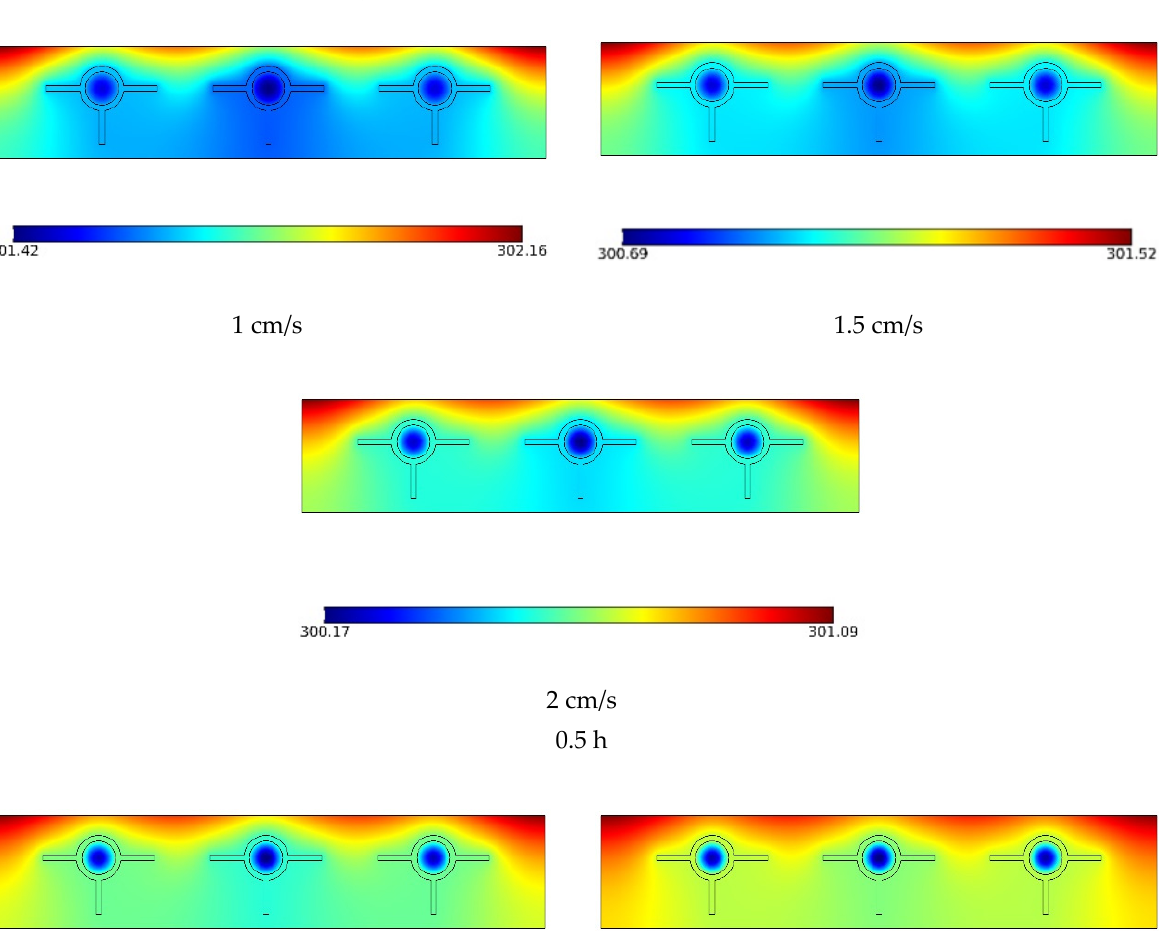
Table 5. Outlet temperature values of water at different flow rates in a solar collector at different hours: a comparison between the present work and the experimental data of Aghakhani et al.